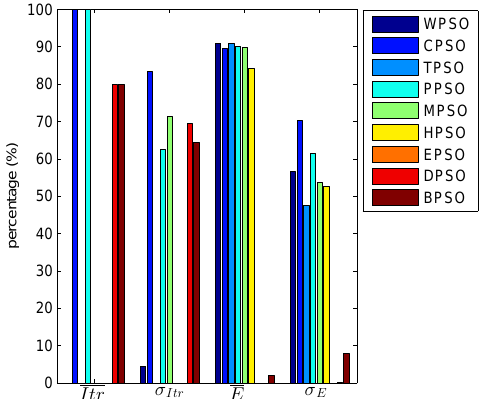
Figure 4. Percentage of PSO-based localization achieving the optimal